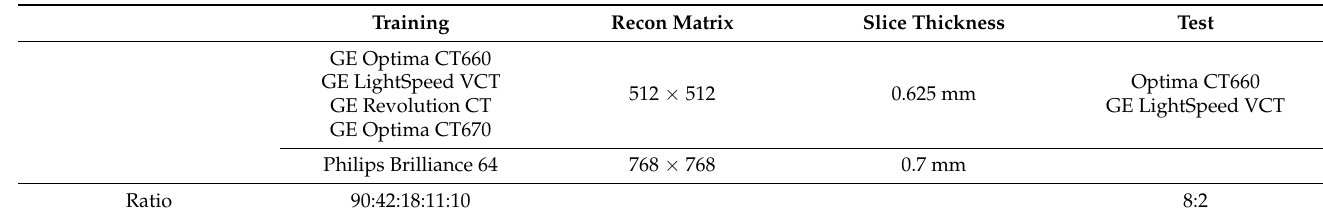
Table 1. Statistics of the enrolled CT